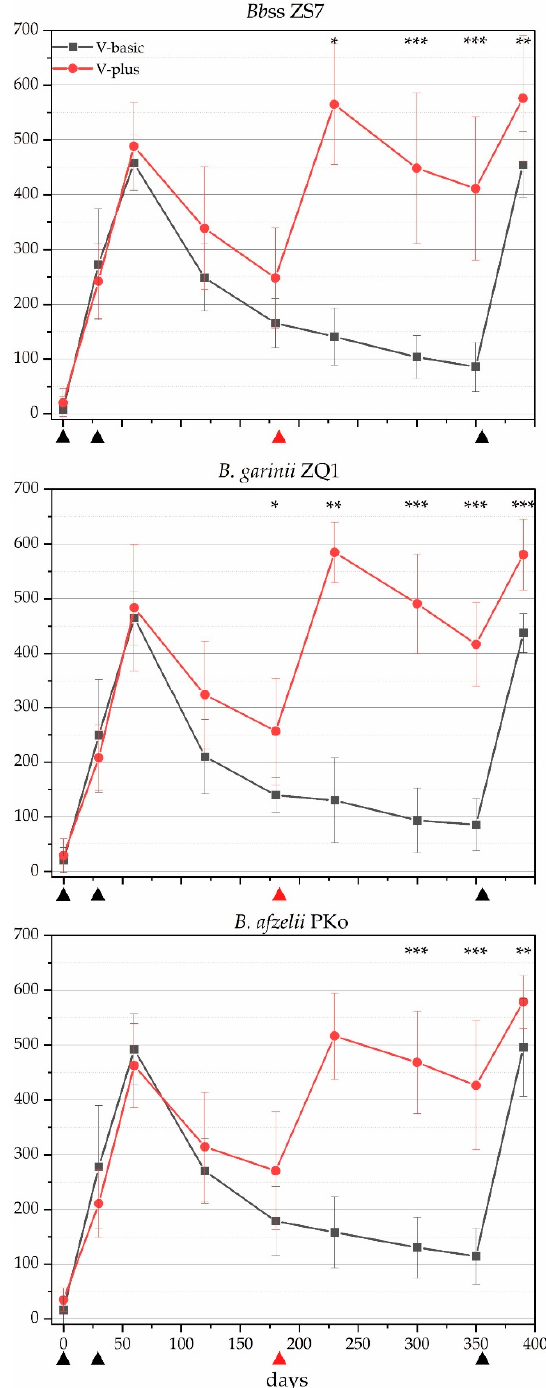
Figure 2. rOspA-specific antibody levels against Borrelia ( B. ) burgdorferi sensu stricto, B. garinii, and B. afzelii detected by the species-specific rOspA KELA. V-basic displayed as black squares; V-plus is shown as red circles. The whiskers depict the standard deviation on the specific time point. Vaccination time points are shown as black triangles in both groups; the red triangle indicates the additional booster vaccination in V-plus. * p ≤ 0.05; ** p ≤ 0.001; *** p ≤ 0.0001.